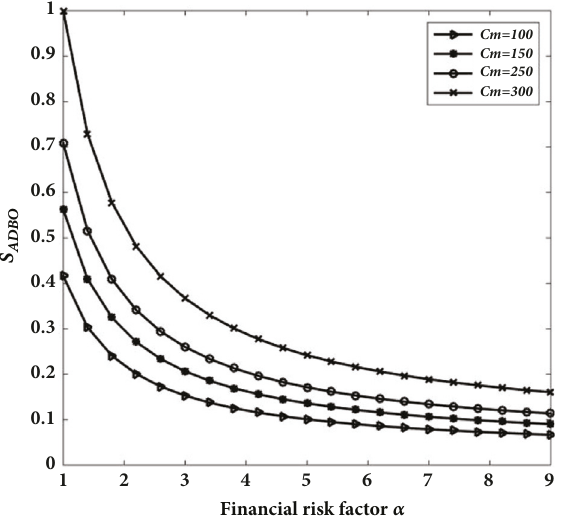
Figure 4: The influence of 𝛼 on 𝑆 𝐴𝐷𝐵𝑂 with different cooperation cost of manufacturer. (𝑉 𝑠 = 308.4436,𝑉 𝑚 = 825.9870, 𝐶 𝑠 = 139.9783,𝛾 = 0.8) .